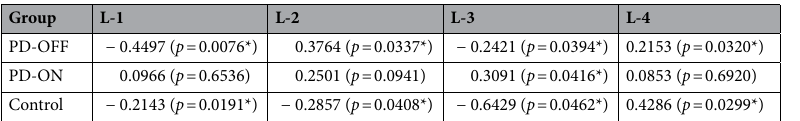
Table 5. Correlation between the endpoint variance and obstacle hit-to-warn ratio. Spearman correlation was applied; the table indicates the correlation coefficient ( r s ) and the corresponding p -value; * indicates statistical significance.